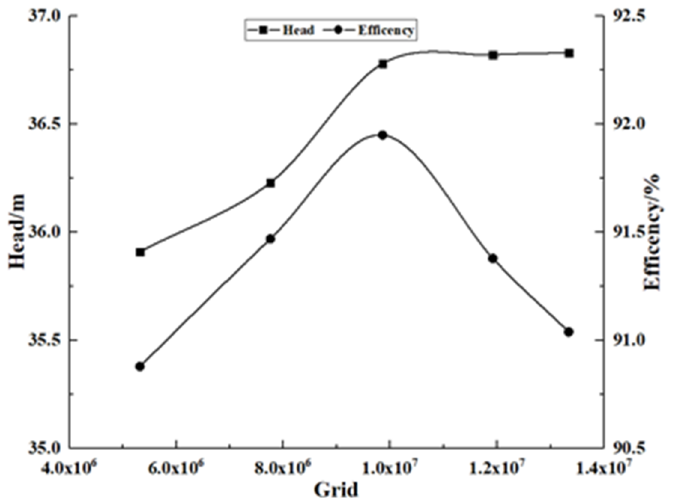
Figure 5. Grid independency.